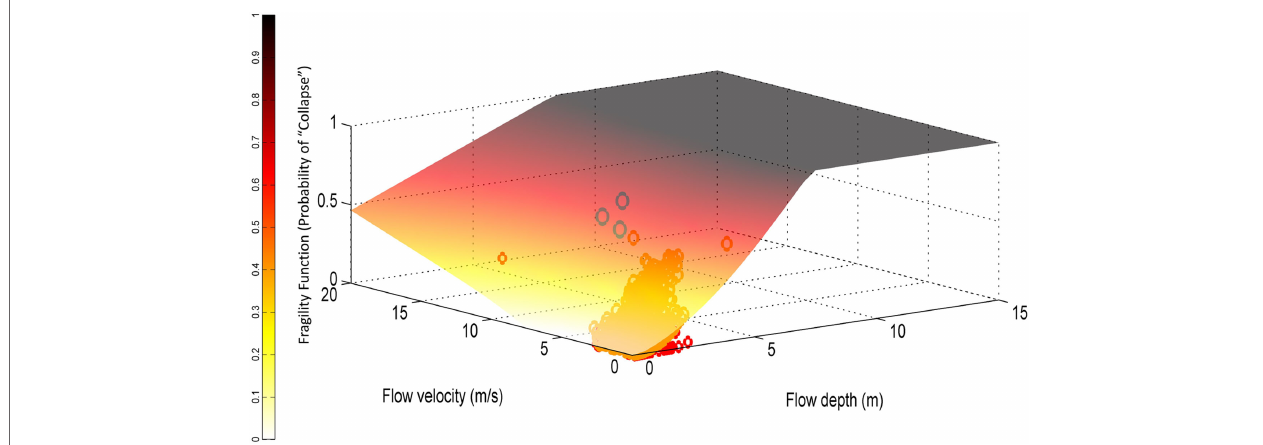
FIGURE 3 | Example tsunami fragility surface showing building collapse probability conditional on two key intensity measures, flow depth and velocity. Adapted from Charvet et al.